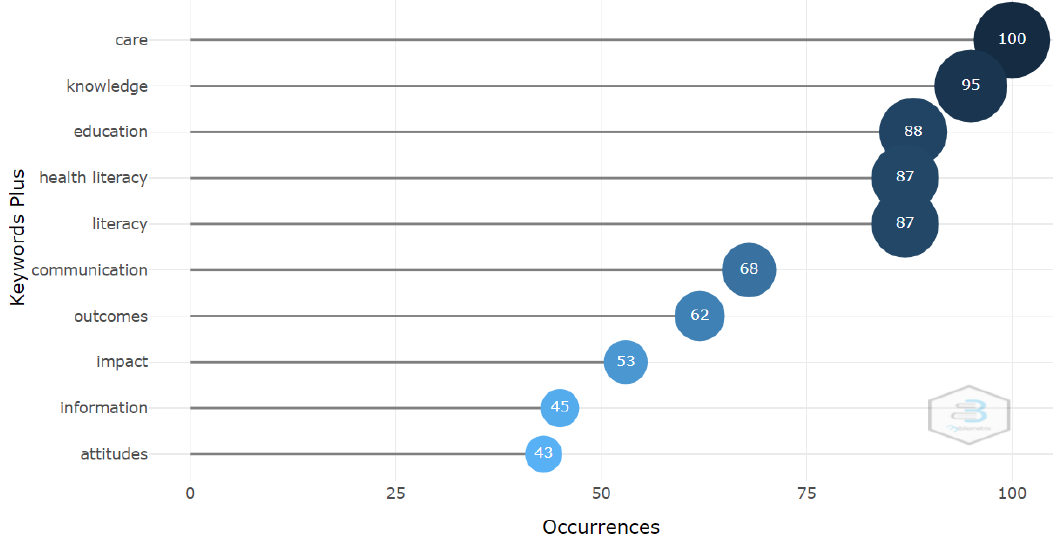
Figure 8. Most relevant KeyWords Plus.